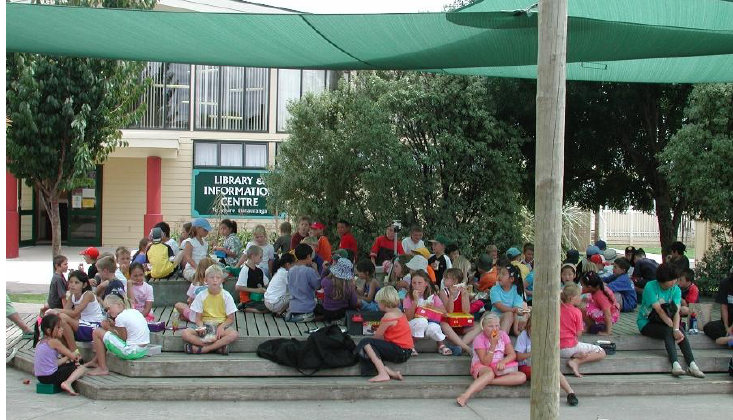
Figure 1. Schoolchildren in New Zealand having lunch outdoors. Note the shade provided by a canopy (courtesy of Christina Mackay, Victoria University of Wellington, New Zealand).